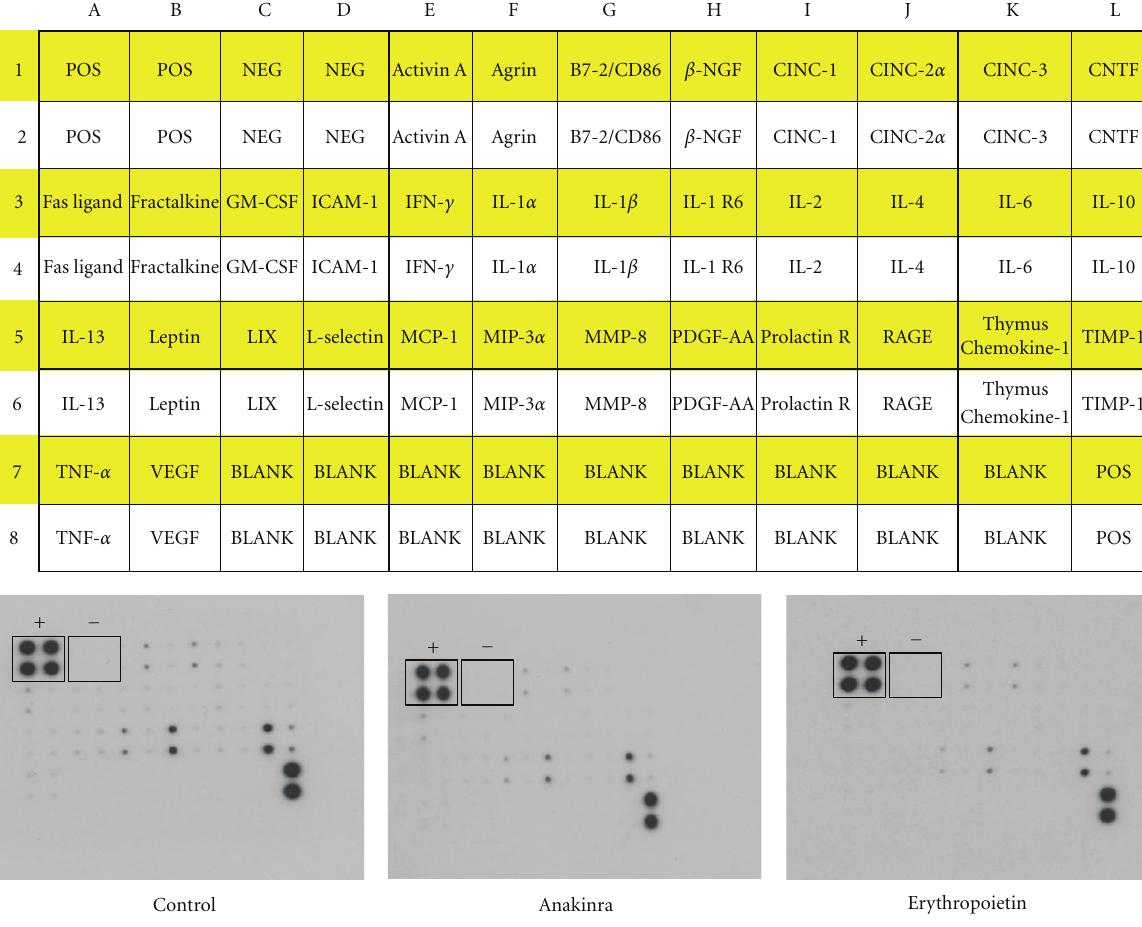
Figure 3: Impact of Anakinra and erythropoietin on circulating inflammatory cytokines. Representative pictures demonstrating no di ff erences in the relative expression levels of inflammatory cytokines depicted as black spots ( N = 4 samples/group, + indicating positive control spots, − indicating negative control spots). Cytokine panel (top) published with kind permission of RayBiotech,